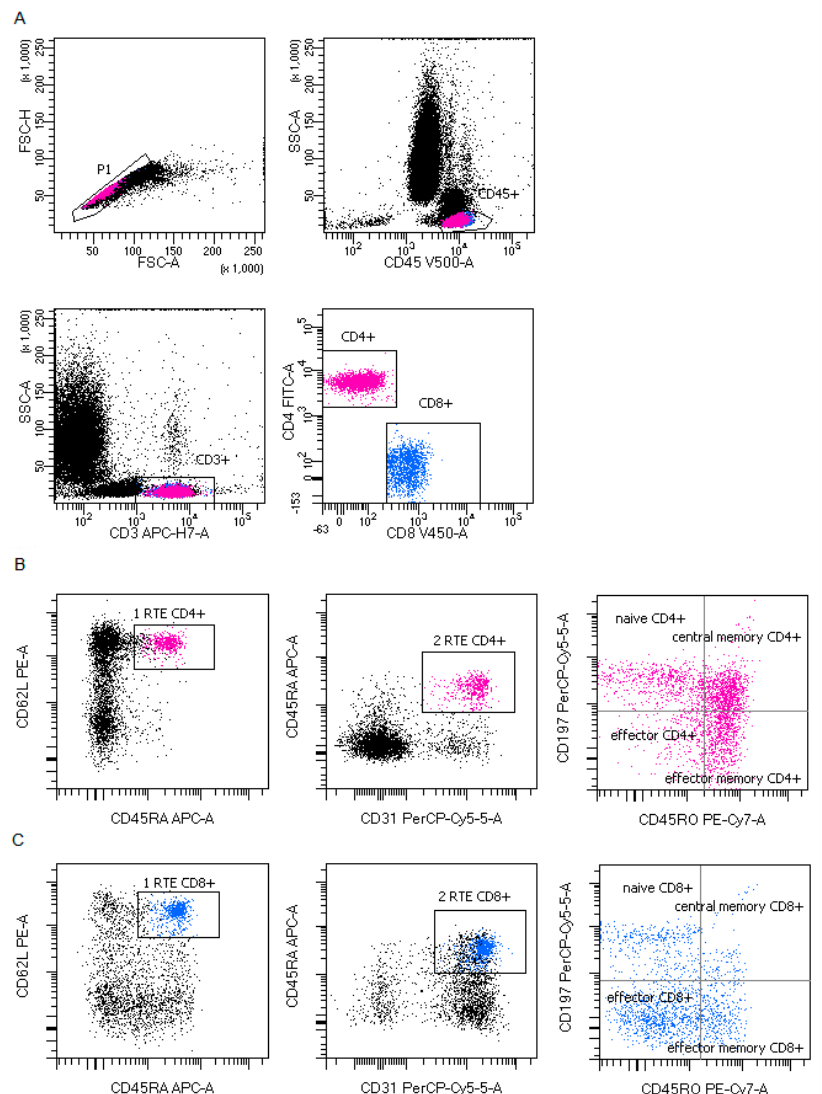
Figure 2. Representative T lymphocytes maturation gating strategy in coronavirus disease 19 (COVID-19) patients. ( A ) T lymphocytes gating strategy: FSC-A vs. FSC-H plot: Gating the cells that have an equal area and height, thus removing clumps (greater FSC-A relative to FSC-H) and debris (very low FSC), CD45 vs. SSC-A plot: Broad selection of lymphocytes based on their SSC/CD45 properties, CD3 vs. SSC-A plot: Broad selection of lymphocytes T based on their SSC/CD3 properties. CD4 vs. CD8 plot: Broad selection of lymphocytes T CD4+ (pink) and CD8+ (blue) based on their CD4/CD8 properties. ( B ) CD4+ T lymphocytes maturation gating strategy for each maturation subsets. CD62L vs. CD45RA plot and CD45RA vs. CD31: Broad selection of CD4+ T lymphocytes based on their CD62L/CD45RA and CD45RA vs. CD31 properties and allow select recent thymic emigrants T CD4+ cells RTE (plot 1: RTE CD4+ and plot 2: RTE CD4+), CD197 vs. CD45RO plot: Broad selection of CD4+ T lymphocytes based on their CD197/CD45RO properties: naïve CD4+ T cells, effector CD4+ T cells, central memory CD4+ T cells and effector memory CD4+ T cells. ( C ) CD8+ T lymphocytes maturation gating strategy for each maturation subsets. CD62L vs. CD45RA plot and CD45RA vs. CD31: Broad selection of CD8+ T lymphocytes based on their CD62L/CD45RA and CD45RA vs. CD31 properties and allow selected recent thymic emigrants T CD8+ cells RTE (plot 1: RTE CD8+ and plot 2: RTE CD8+), CD197 vs. CD45RO plot: Broad selection of CD8+ T lymphocytes based on their CD197/CD45RO properties: Naïve CD8+ T cells, effector CD8+ T cells, central memory CD8+ T cells and effector memory CD8+ T cells.